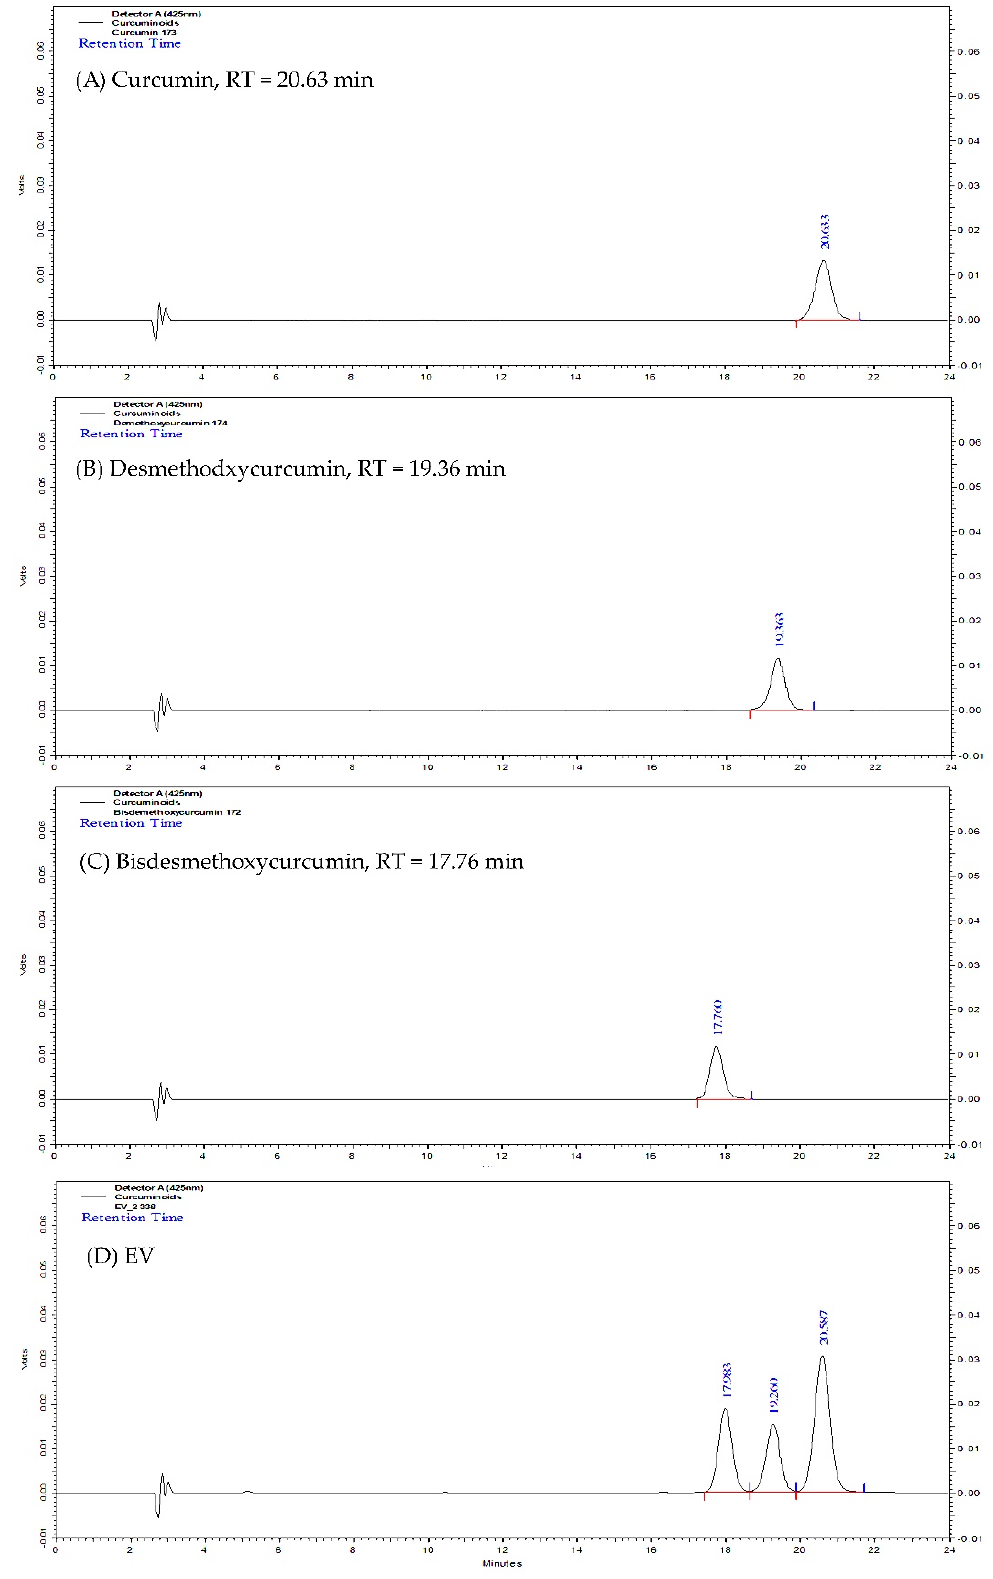
Figure 2. HPLC fingerprint of standard curcumin ( A ); standard desmethoxycurcumin ( B ); standard bisdesmethoxycurcumin ( C ); and turmeric rhizome ethanol extract (EV, ( D )).